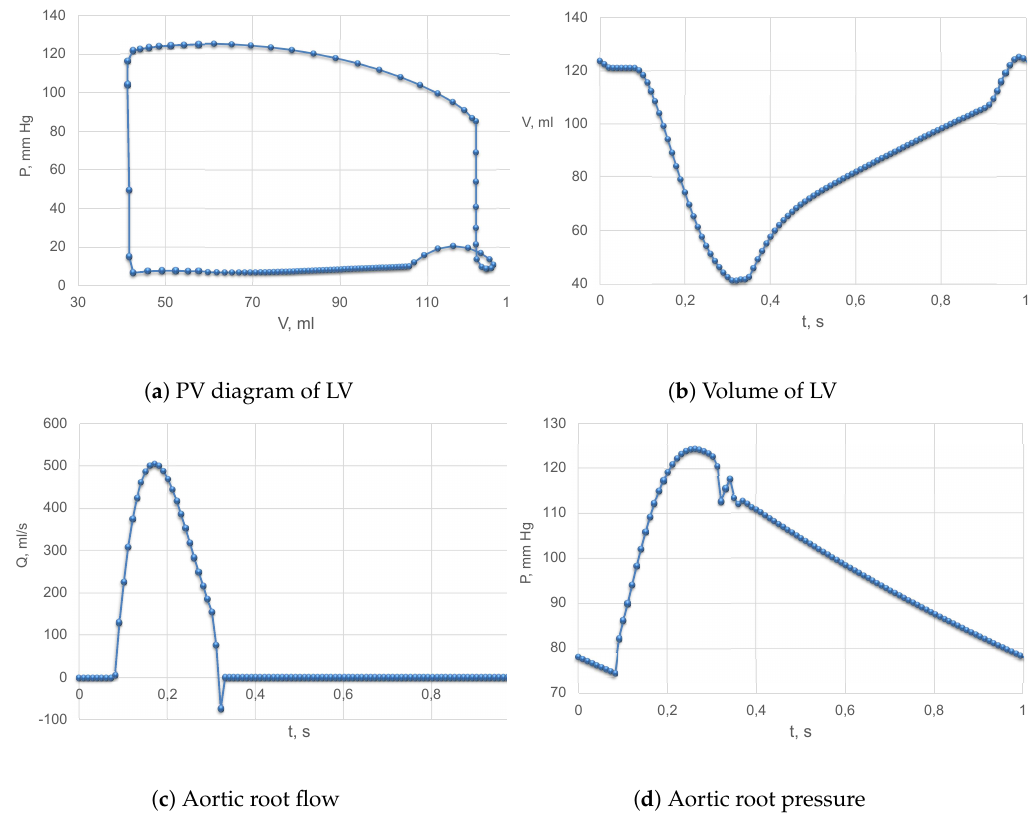
Figure 2. Validation of the integrated model for the heart and the